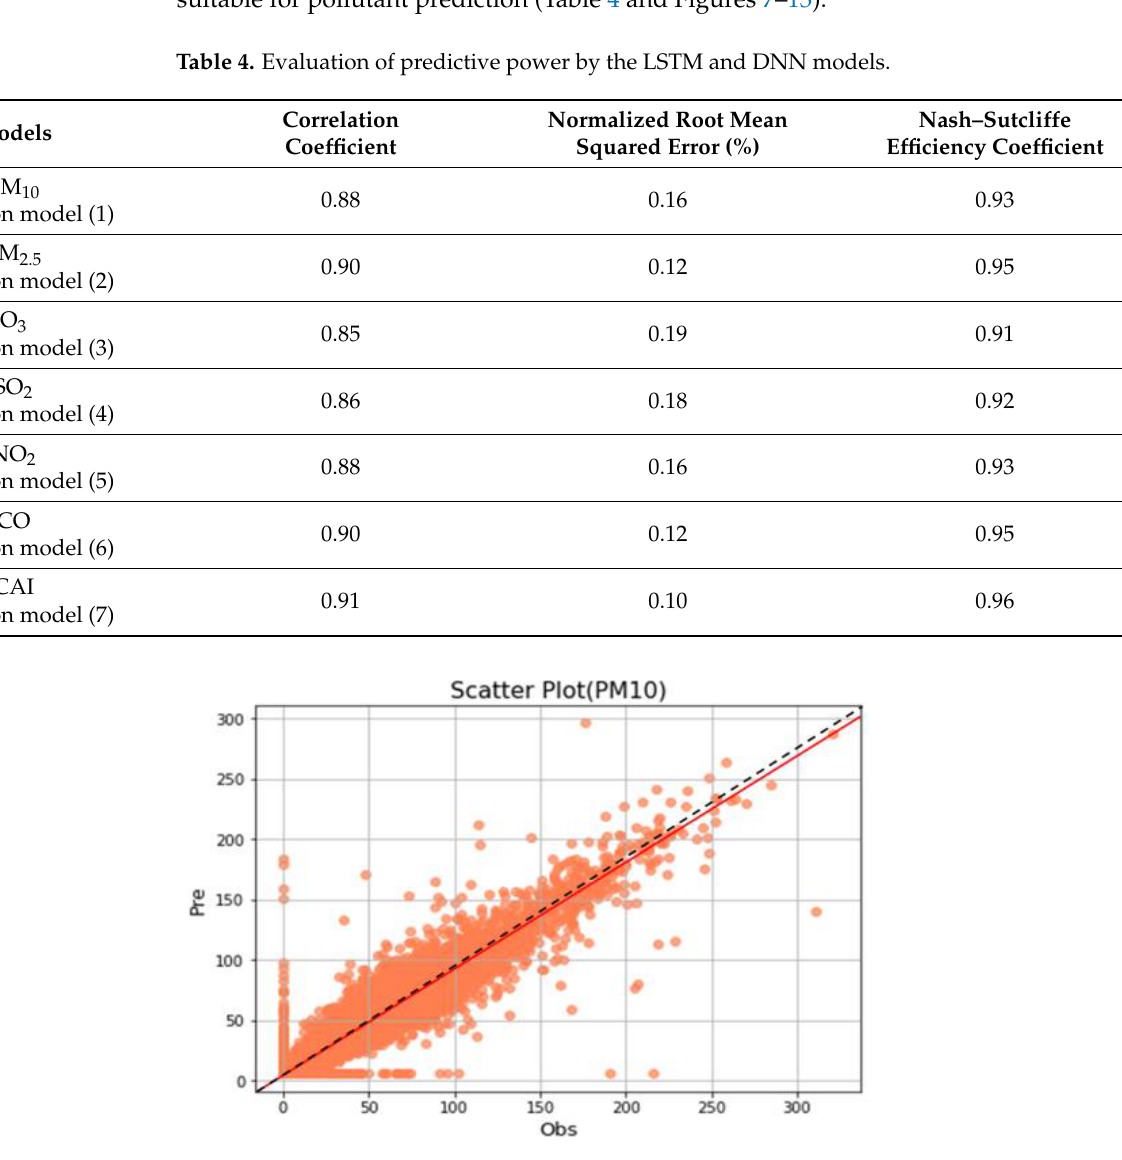
Figure 8. Comparison results of predicted fine particulate matter with observations. The regression line of observed and predicted data is indicated in red. Figure 9. Comparison results of predicted ozone with observations. The regression line of observed and predicted data is indicated in red. Figure 10. Comparison results of predicted sulfurous acid gas with observations. The regression line of observed and predicted data is indicated in red.